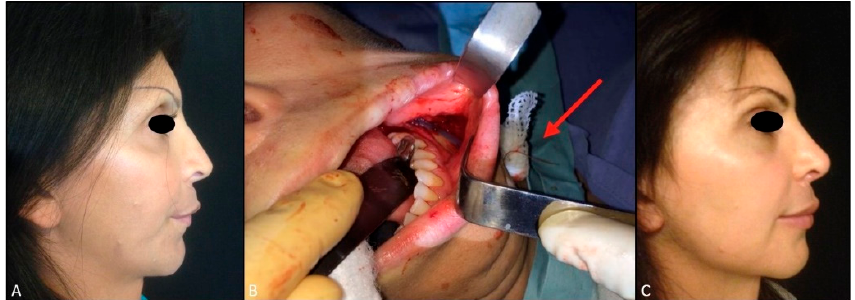
Figure 6. Pre-operative ( A ), intraoperative view of the implant placement ( B ), and one-year follow-up ( C ) results of a 42-year-old transgender patient having a Jaw angle lengthening implant insertion. During the same operating time, secondary rhinoplasty, superior and inferior lip implants, canthopexy, orbital rim remodeling, otoplasty, and full facial CO2 treatment were also performed. In ( B ) the red arrow points to the anchoring suture used to insert and fix the implant.